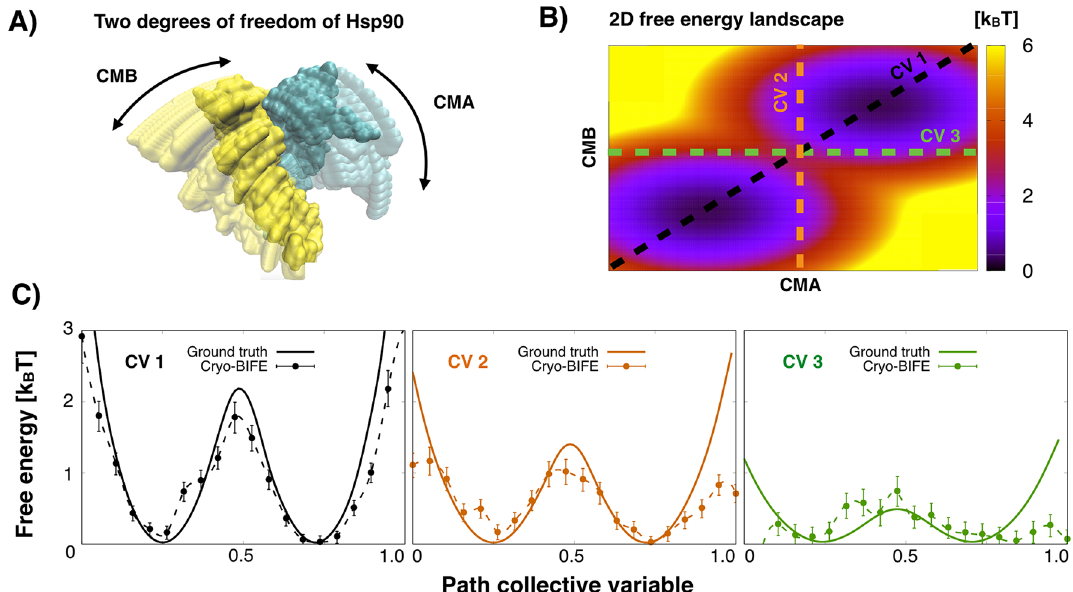
Figure 4. 2D analysis of Hsp90. ( A ) Two degrees of freedom of Hsp90 along the CMA and CMB rotation directions (see the Methods). ( B ) Ground truth free-energy surface along CMA and CMB directions. Black (CV1), orange (CV2) and green (CV3) dashed lines show three paths used for the cryo-BIFE analysis. ( C ) The free-energy profiles along these three path CVs, extracted with cryo-BIFE using synthetic particle images (dashed lines), are compared to the ground truth projected profiles (solid lines). The R-hat test for the MCMC yielded values < 1.003 for all cases. The bars show the credible interval at 5% and 95% of the empirical quantile at each node. The results are for the second BioEM round of orientation